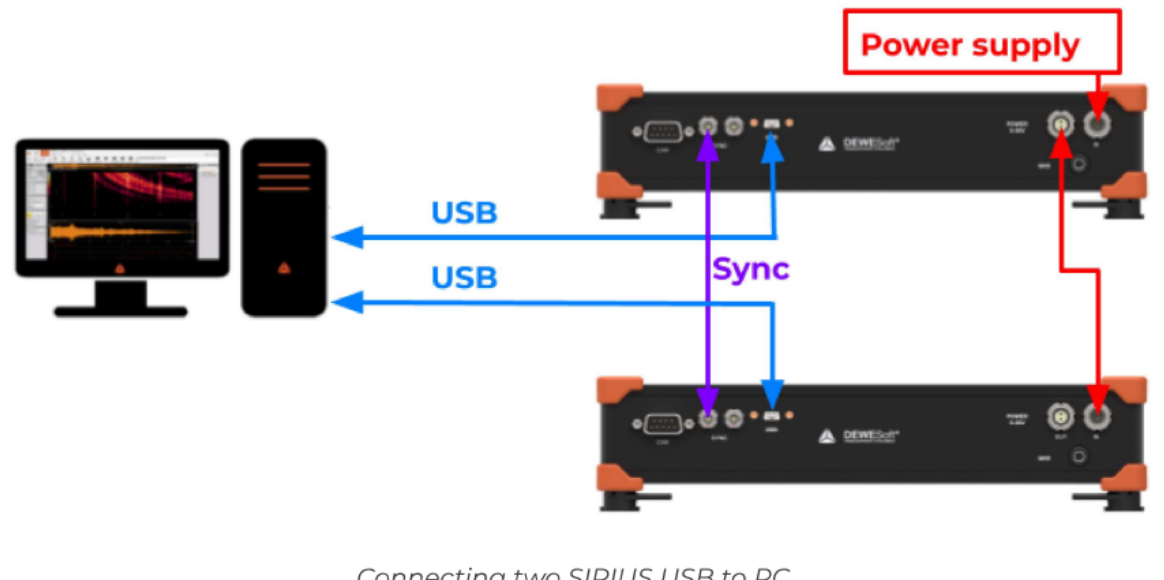
Figure 3. Two chassis were combined and synced to obtain a sixteen-channel solution.